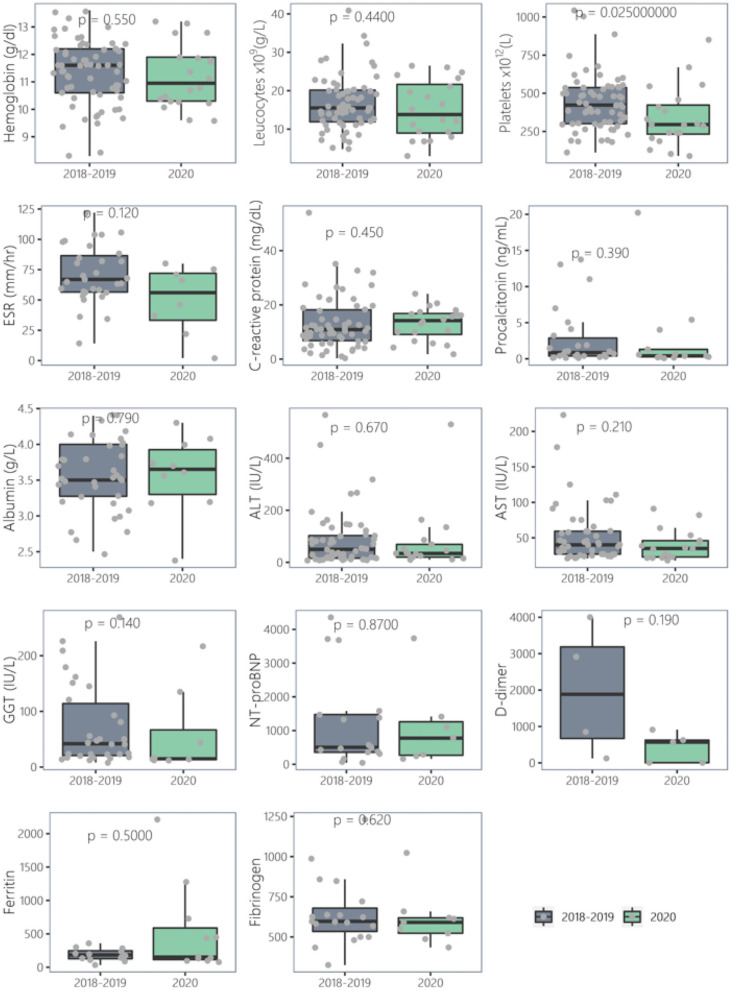
Comparison of laboratory results of Kawasaki disease cases (2018–2019) vs. 2020 (CoV–).